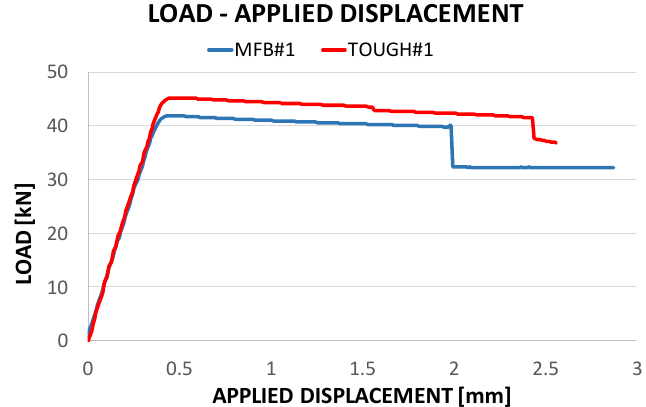
Figure 15. Compressive load vs applied displacements.